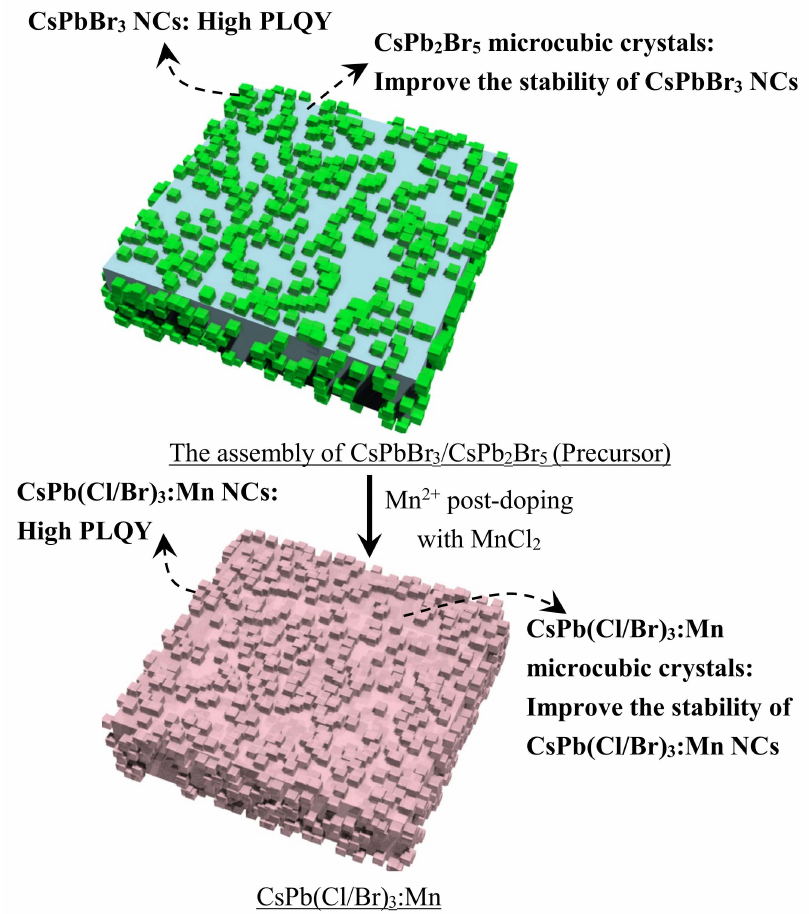
Figure 12. Schematics of PL and stability enhancement mechanism of the CsPbBr 3 precursor and the optimum CsPb(Cl/Br) 3 :Mn product.